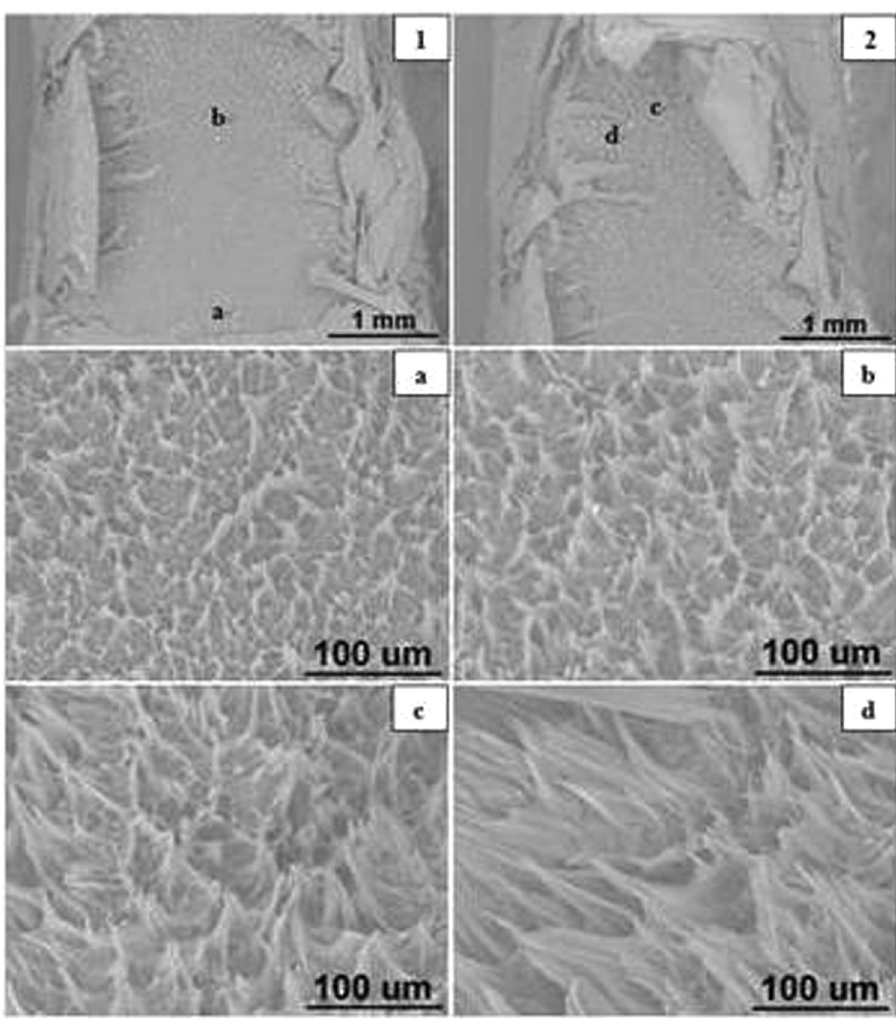
Figure 11. SEM images of blunt notched HDPE fracture surfaces at 0.05 mm/min (1) notch at the bottom, crack propagating from bottom to top; (2) top of propagation at 25